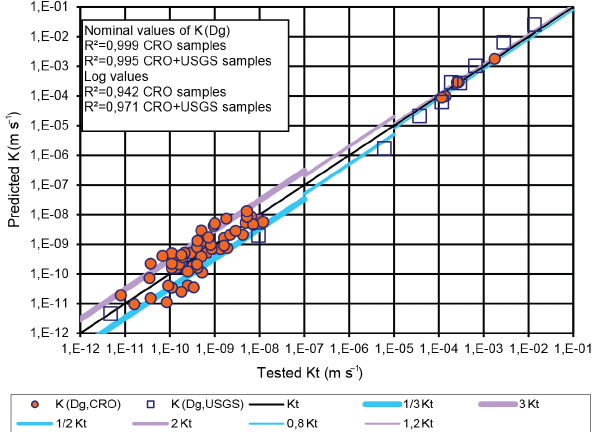
Figure 14. Verification of graphical and numerical correlation be- tween the tested K t and the predicted hydraulic conductivity K(D g ) using referential geometric mean size for all